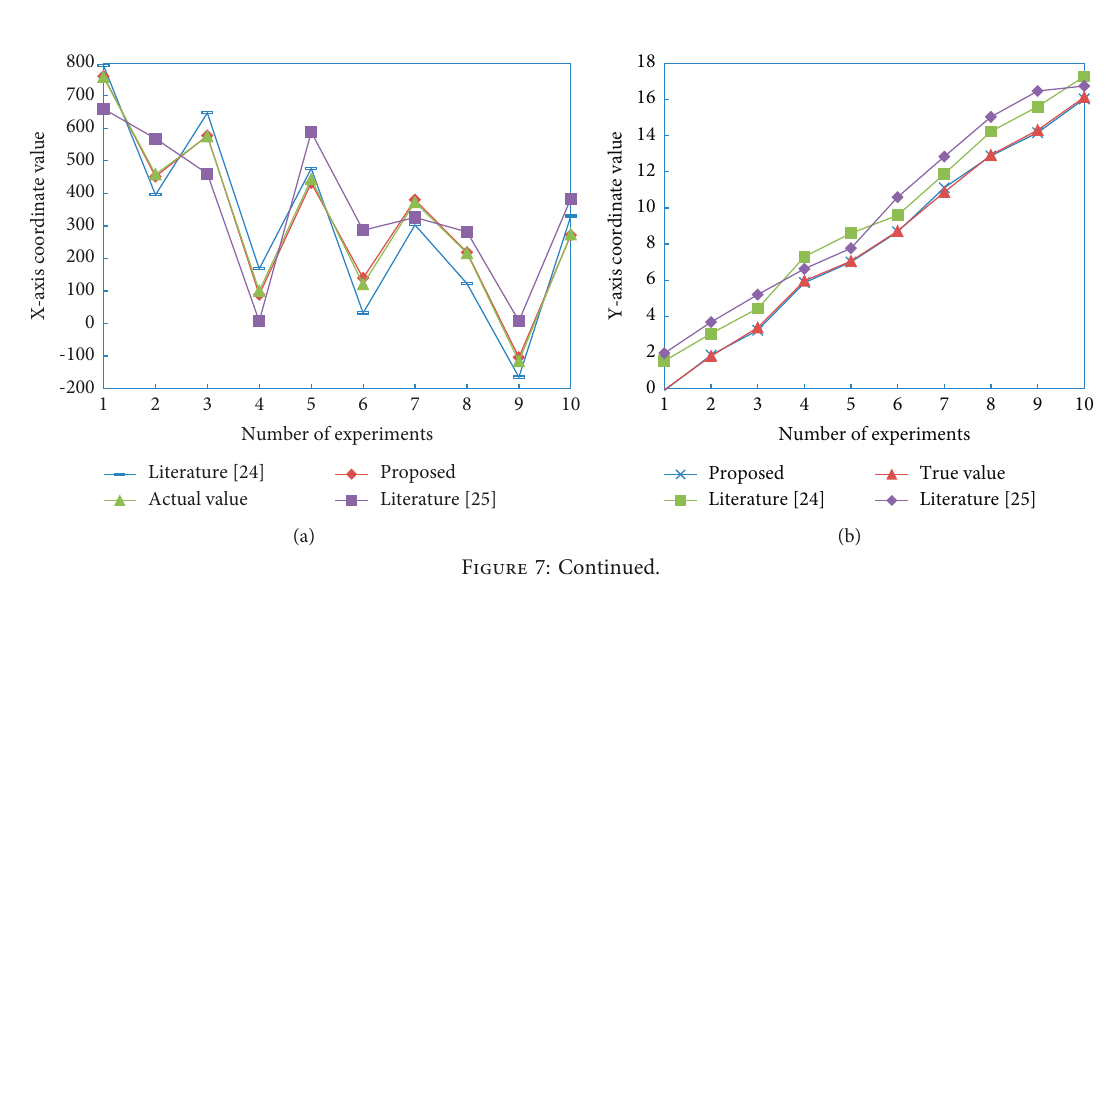
Figure 6: Joint 5 and joint 6 curves of manipulator.